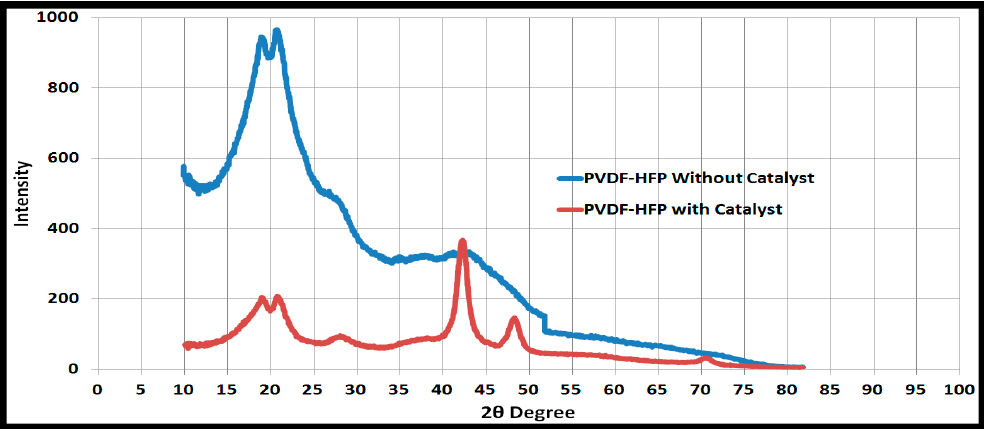
Figure 5. X-Ray Defraction ( XRD) plots of PVDF-HFP with and without catalytic nanoparticles.